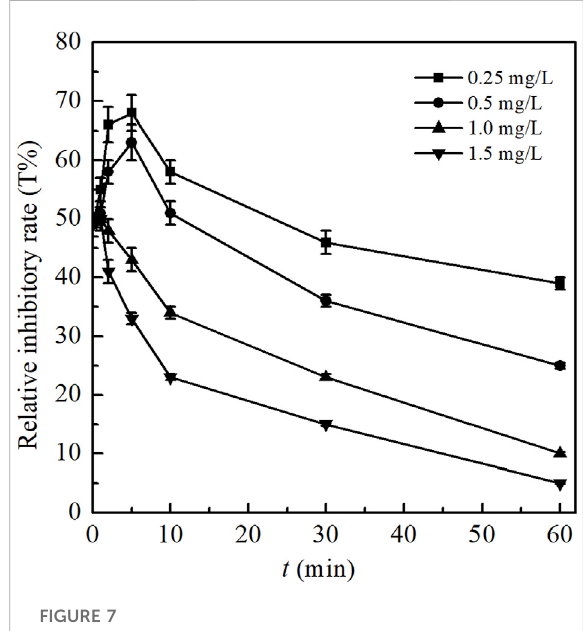
FIGURE 7 Toxicity evolution during BPA degradation by ozonation at different ozone dosages. (Experimental conditions: [BPA] 0 = 1.00 mg/L; temperature = 25 ± 1 ° C; initial solution pH = 7.0; O